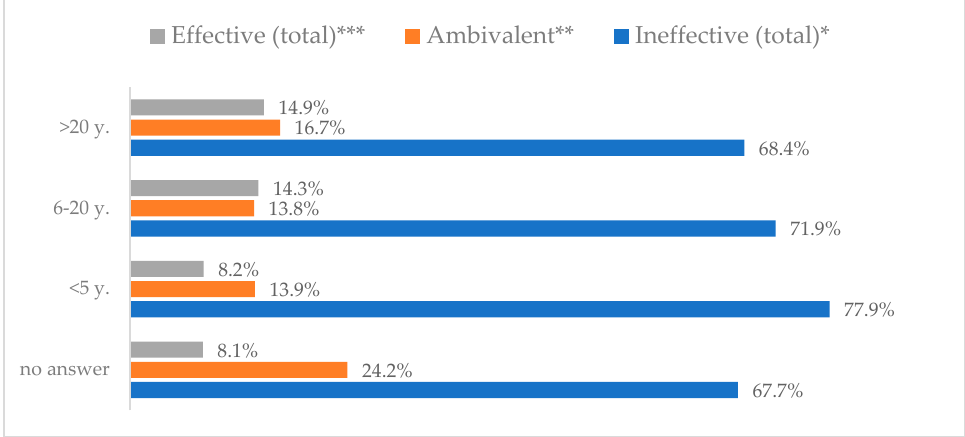
Figure 30. Taking preparations with inosine to prevent influenza virus infection by seniority ( N = 905). *Sum of responses: completely ineffective, ineffective, rather ineffective; **Response: neither ineffective nor effective; ***Sum of responses: rather effective, effective, completely effective.